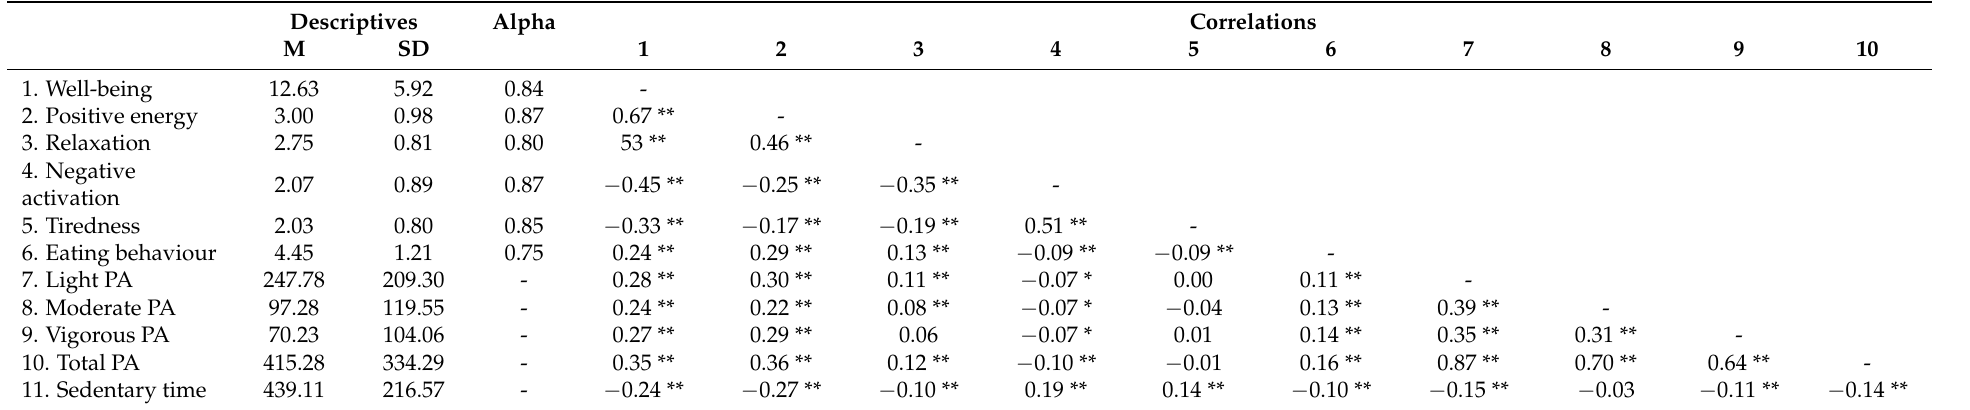
Table 1. Descriptive statistics, Cronbach’s alpha, and